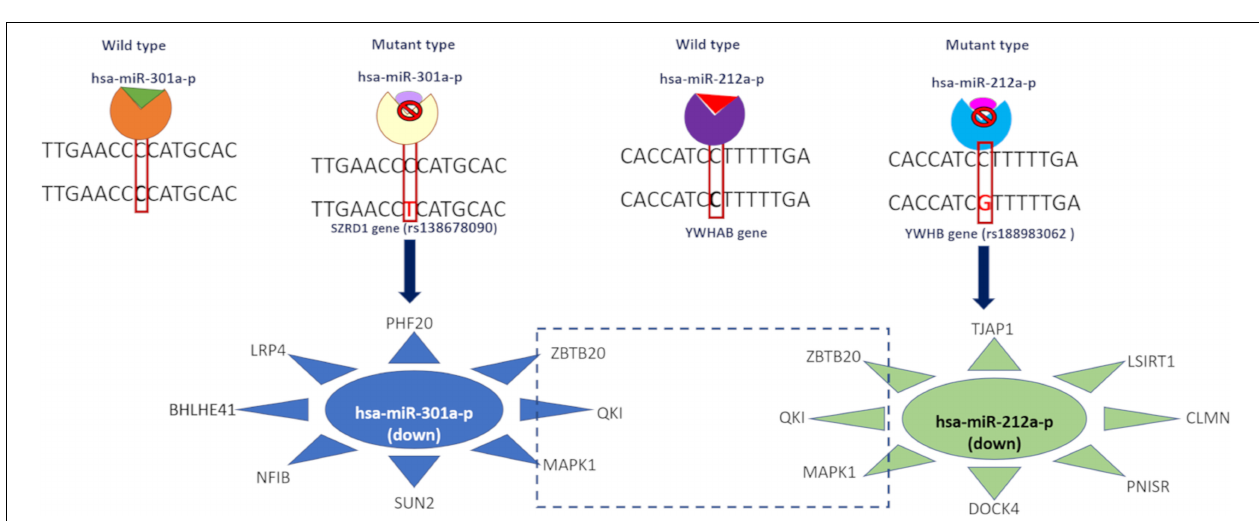
neuronal cell survival. Figure 4 denotes that CHD9 activates CREBBP, and both TFs are upregulated in AD and PD. NCOR1 and JUN inhibit CREBBP, and these TFs are downregulated and co-expressed in BA9. KAT2B and FGFR1 interact with CREBBP, and these genes are co-exprssed and upregulated in AD and